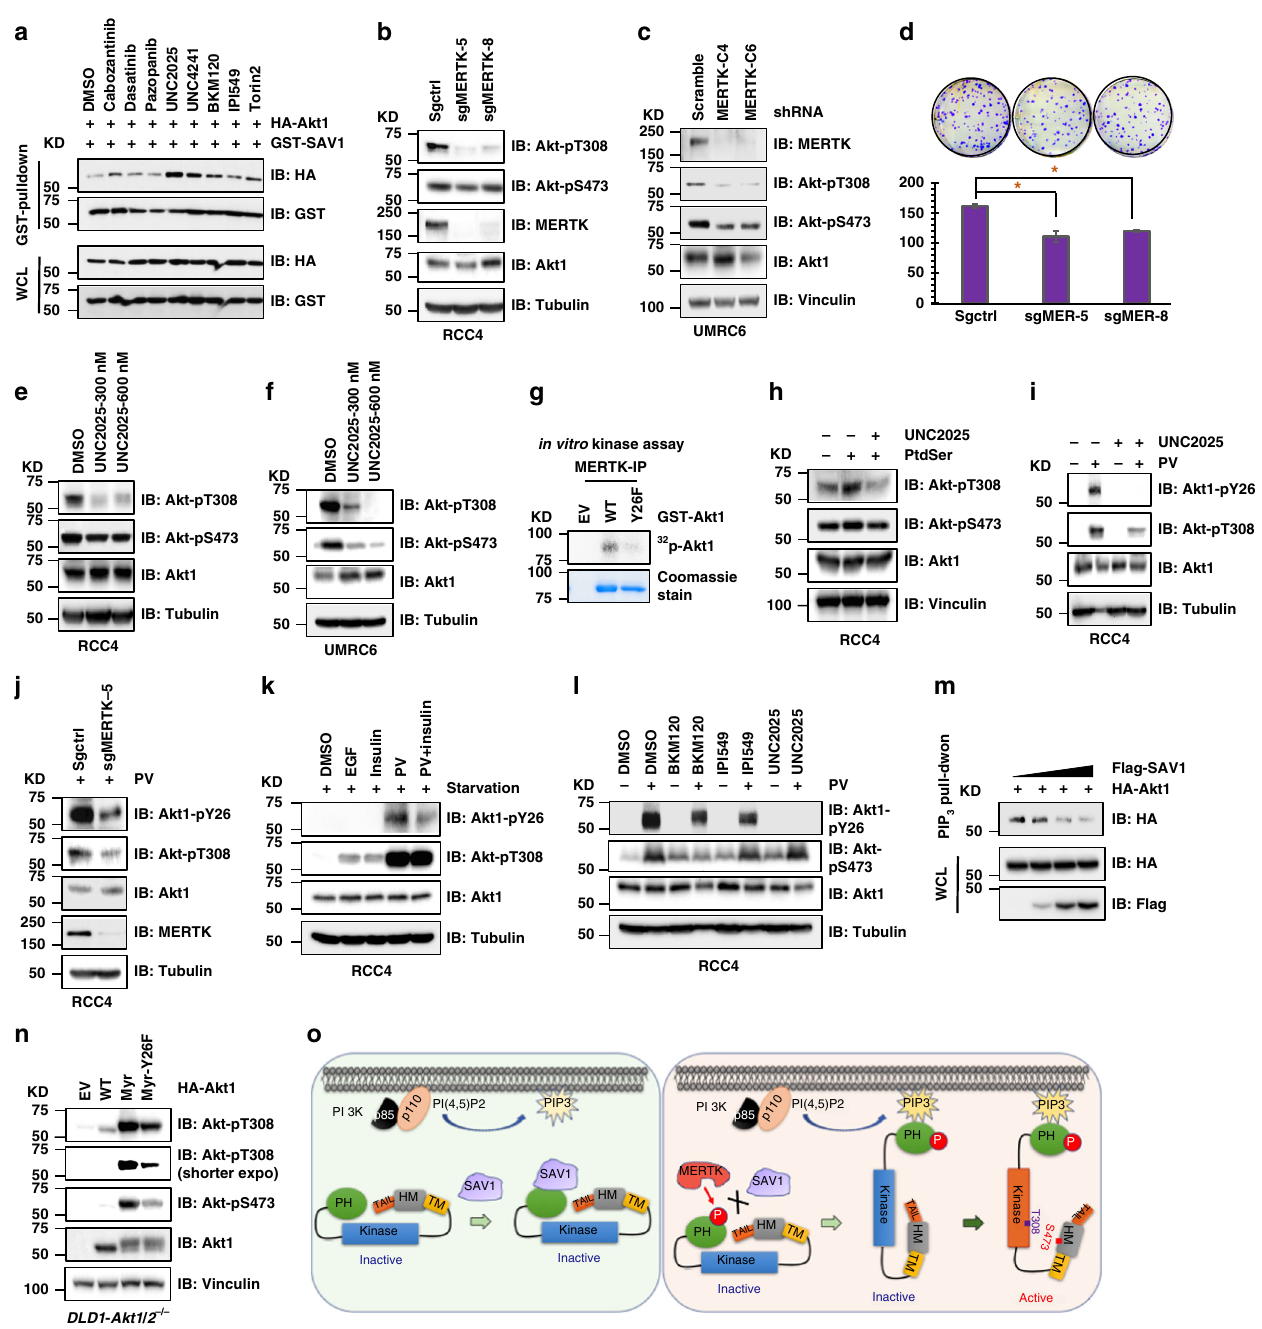
Fig. 2 MERTK phosphorylates and activates Akt by releasing SAV1 binding. a IB analysis of WCL and GST-pulldown products derived from HEK293 cells transfected with CMV-GST-SAV1 and HA-Akt1 constructs and treated with indicated kinase inhibitors for 12 h before cell collection. Doses for inhibitors used as following: cabozantinib (c-Met and VEGFR2 inhibitor, 100 nM), dasatinib (Src inhibitor, 100 nM), pazopanib (VEGFR inhibitor, 100 nM), UNC2025 (MERTK inhibitor, 300 nM), UNC4241 (MERTK inhibitor, 300 nM), BKM120 (PI3K α inhibitor, 100 nM), IPI549 (PI3K γ inhibitor, 100 nM), and Torin 2 (mTOR inhibitor, 100 nM). b IB analysis of WCL derived from RCC4 cells deleted of endogenous MERTK using indicated sgRNAs by CRISPR-Cas9. c IB analysis of WCL derived from UMRC6 cells depleted of endogenous MERTK using indicated shRNAs. d Deletion of MERTK in RCC4 cells leads to reduced colony formation ability. e , f IB analysis of WCL derived from RCC4 ( e ) or UMRC6 ( f ) cells treated with indicated MERTK inhibitors with indicated doses for 2 h. g In vitro kinase assays to demonstrate that MERTK directly phosphorylates the Akt1-Y26 in vitro. h – j IB analysis of WCL derived from RCC4 cells treated with 80 μ M phosphatidylserine (PtdSer) ( h ) or 10 μ M pervanadate (PV) ( i , j ) for 30 min in the absence or presence of 300 nM MERTK inhibitor UNC2025 ( h , i ) or MERTK deletion by CRISPR ( j ). k , l IB analysis of WCL derived from RCC4 cells serum starved overnight and then treated with indicated stimulation and inhibitors. EGF (100 ng/ml, 10 min), insulin (100 nM, 30 min), PV (60 μ M, 30 min), BKM120 (200 nM, 10 h), IPI549 (100 nM, 10 h), UNC2025 (300 nM, 2 h). m IB analysis of WCL and PI(3,4,5)P 3 beads pulldown products derived from RCC4 cells transfected with indicated DNA constructs. n IB analysis of WCL derived from DLD1-Akt1/2 − / − cells transfected with indicated HA-Akt1 constructs. o A cartoon illustration indicating that MERTK-mediated Akt1-Y26 phosphorylation releases SAV1 binding and promotes Akt